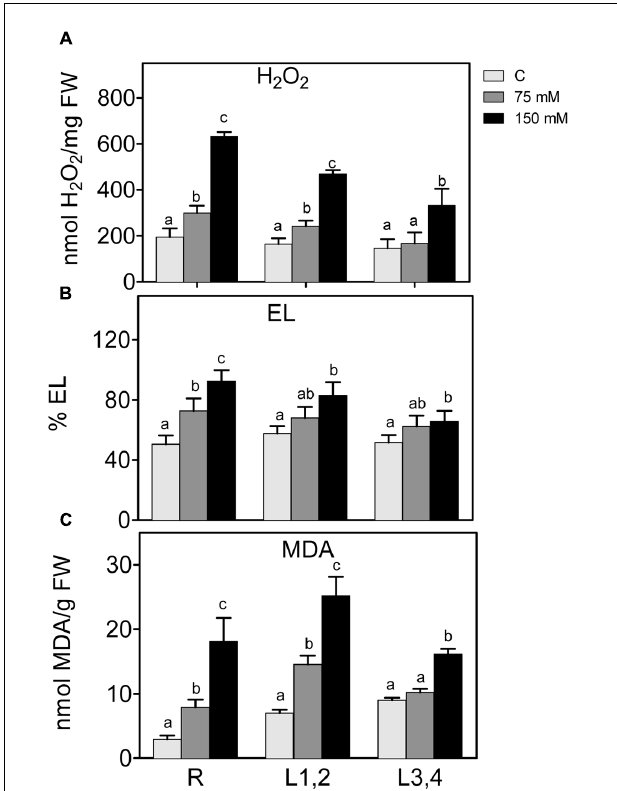
FIGURE 3 | Effect of different salinity levels on H 2 O 2 (A) relative electrolyte leakage (EL, B), and lipid peroxidation measured as malondialdehyde content (C) of root (R), mature leaf pair (L1,2), and young leaf pair (L3,4) of 3 weeks old maize seedlings. Values are means of at least three replicates and significant differences between means, as determined by Duncan test ( P < 0.05), are indicated by different